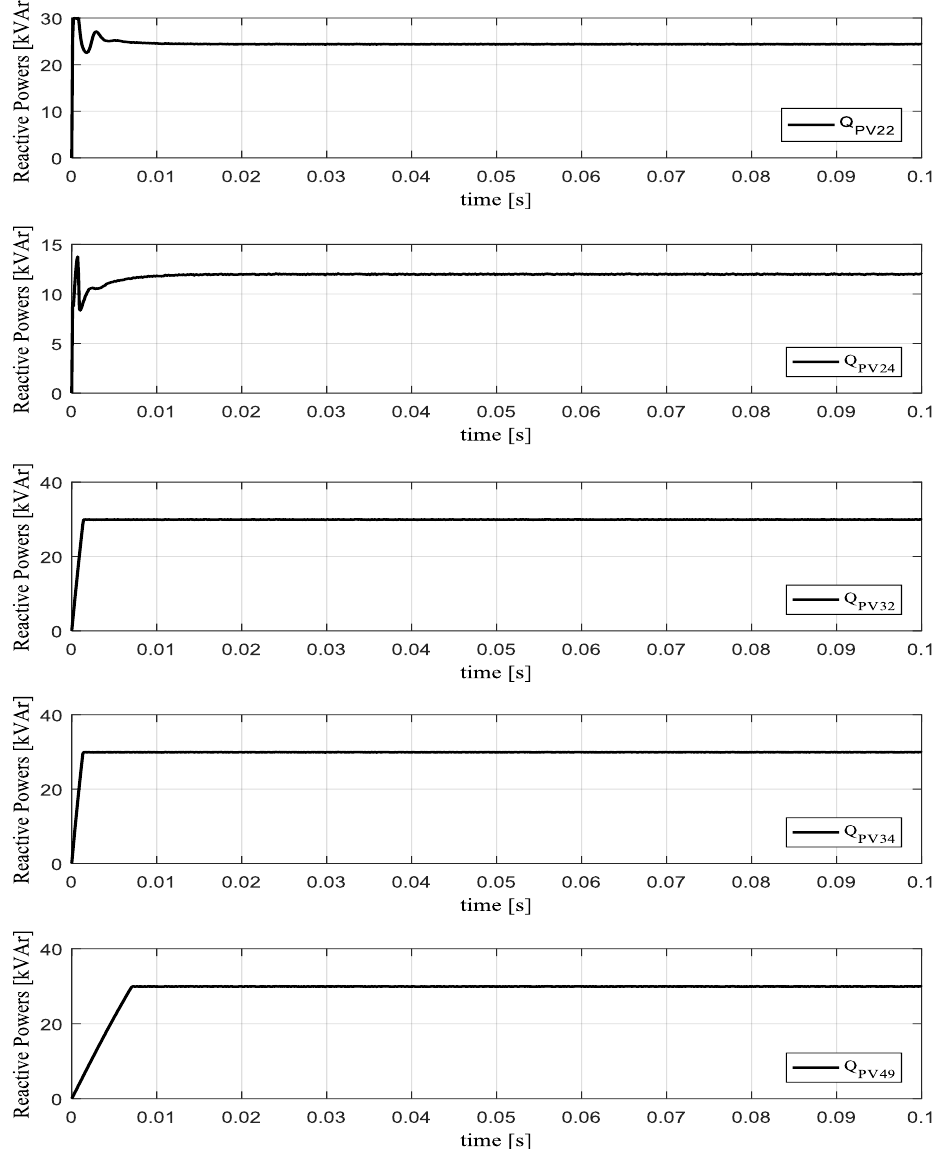
Figure 8. The estimated reactive power control laws at the PV-inverters.